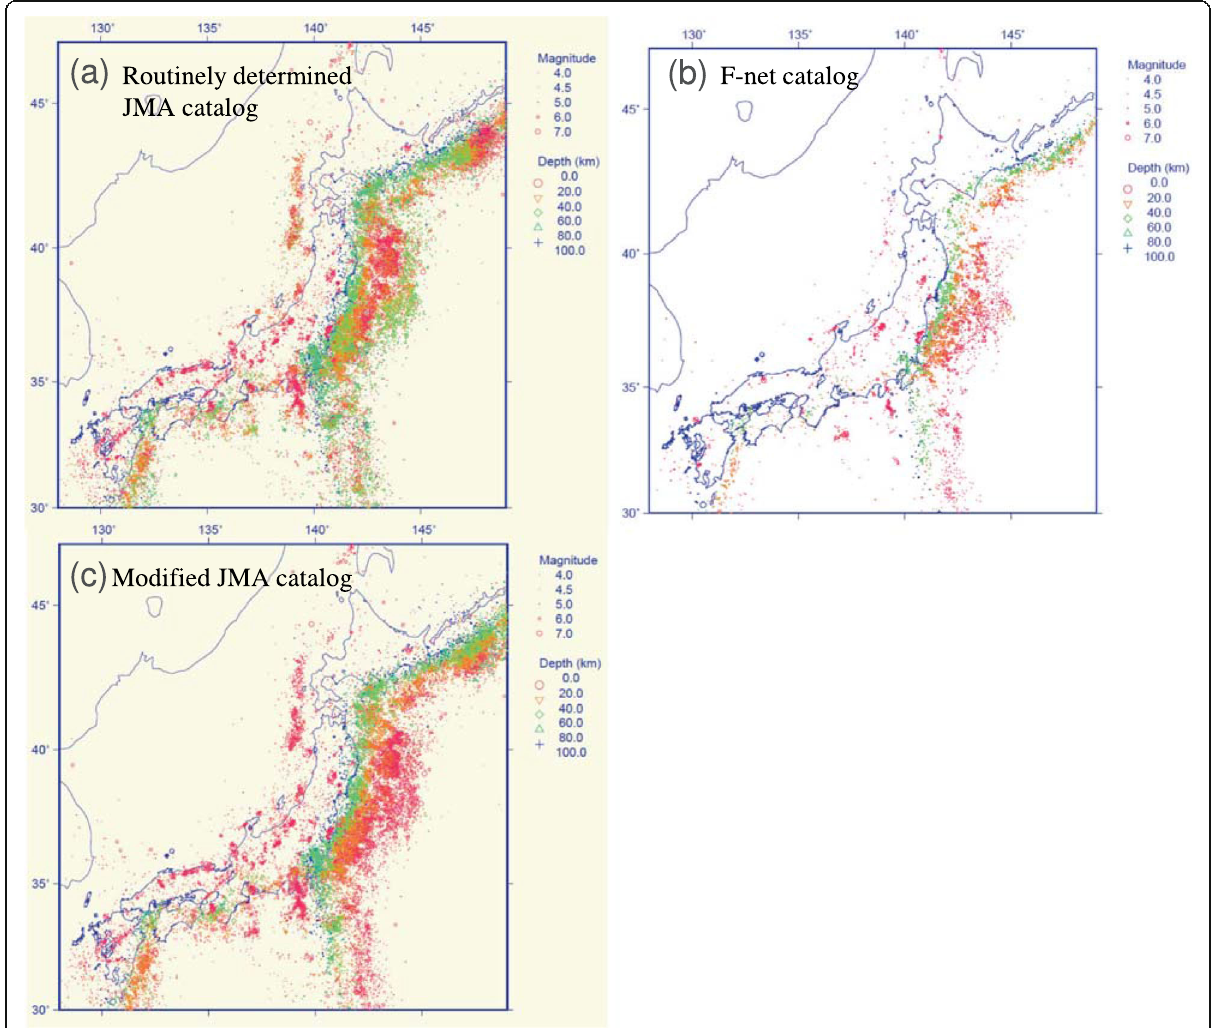
Fig. 9 Depth corrections of offshore earthquakes from the JMA catalog (example 2). a Routinely determined M ≥ 3 earthquake hypocenters in JMA catalog (2000 – 2006) and c corrected hypocenters using of F-net catalog ( b